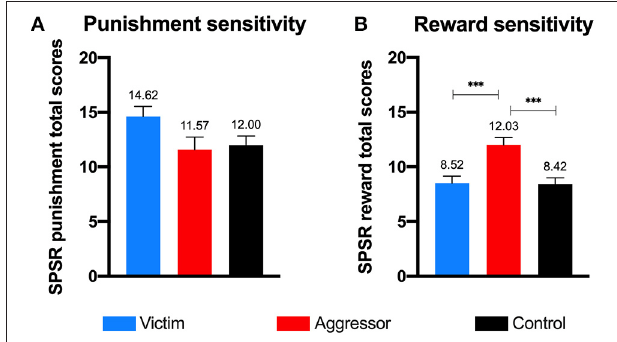
FIGURE 3 | Emotional sensitivity (A) , difficulties in emotional regulation (B) , psychological adjustment in the past (C) , and self-esteem (D) by group. Error bars represent Standard Error of Mean; * p < 0.05; ** p < 0.01; *** p < 0.001.